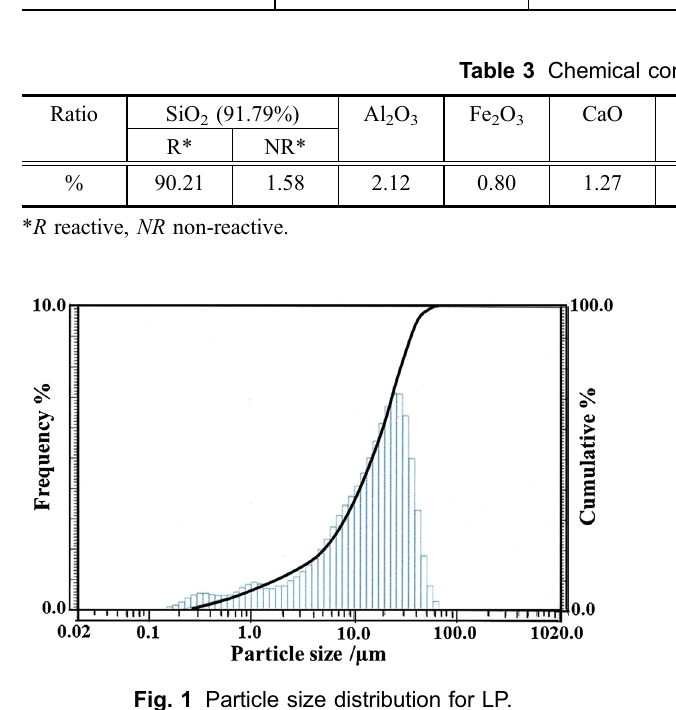
Fig. 1 Particle size distribution for LP.